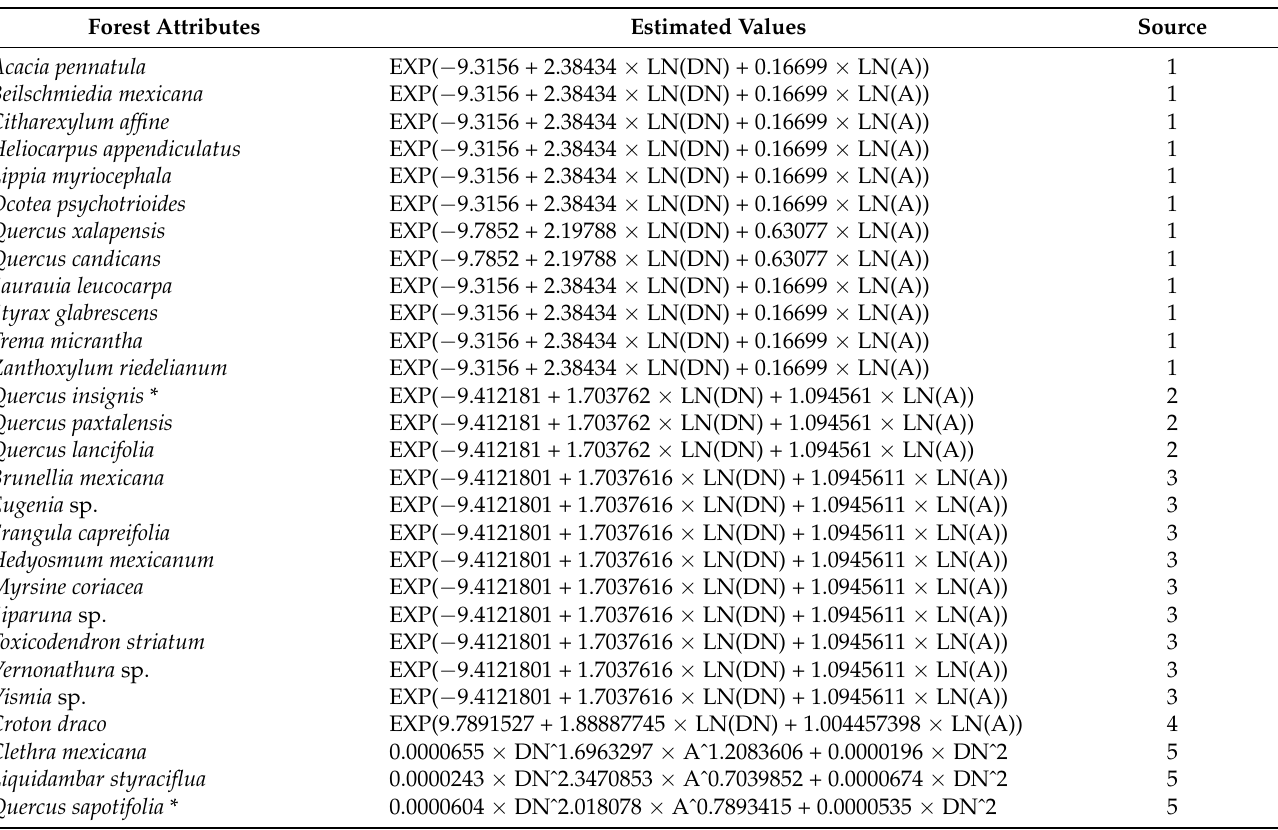
Table A1. Equations used to estimate the volume of timber for tree species in secondary cloud forest using tree diameter (DN) and height (A). The volume includes the trunk and